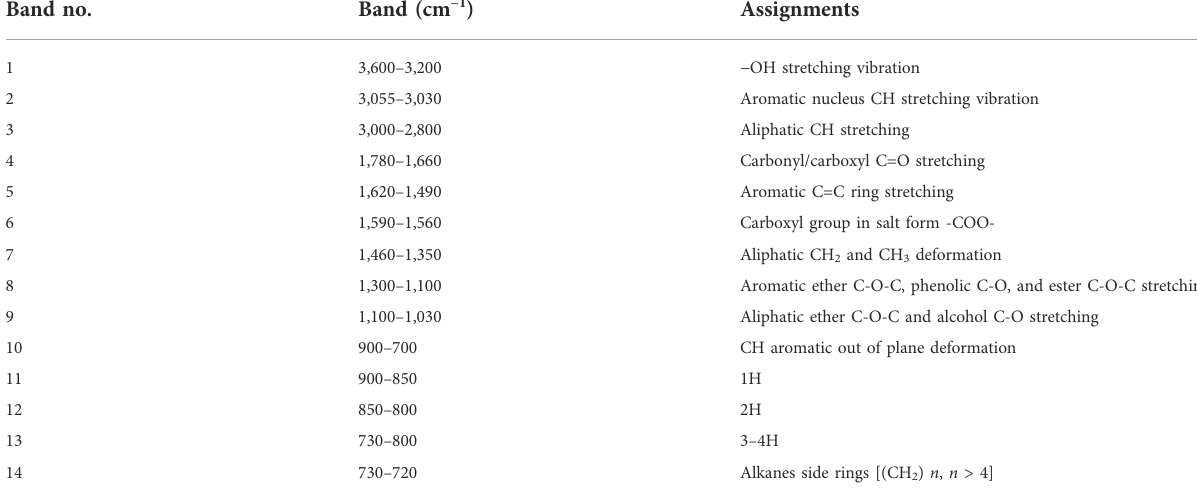
TABLE 3 Band assignments of the functional groups in the coal FTIR spectra (Painter et al., 1981; Ibarra et al., 1996; Dutta et al., 2013; Li et al., 2015a; Jiang et al., 2019; Wang et al., 2022b). Band